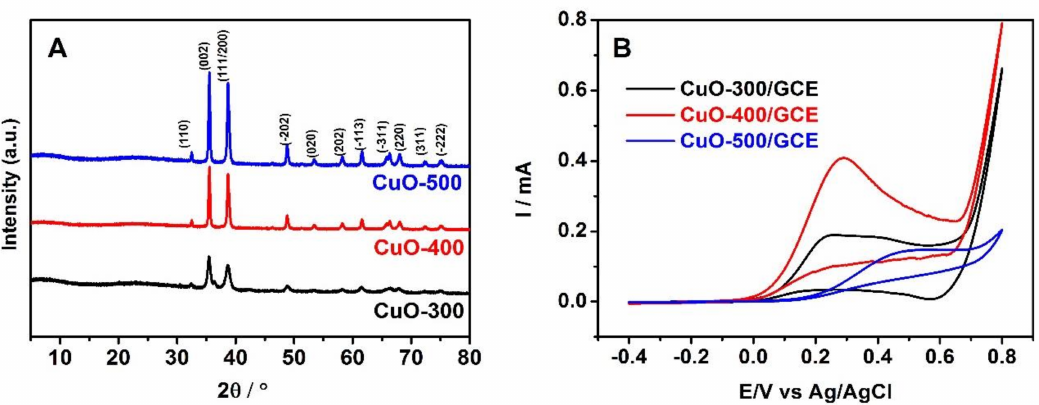
Figure 2. The PXRD patterns ( A ) and CV curves ( B ) of nano-CuO obtained at di ff erent